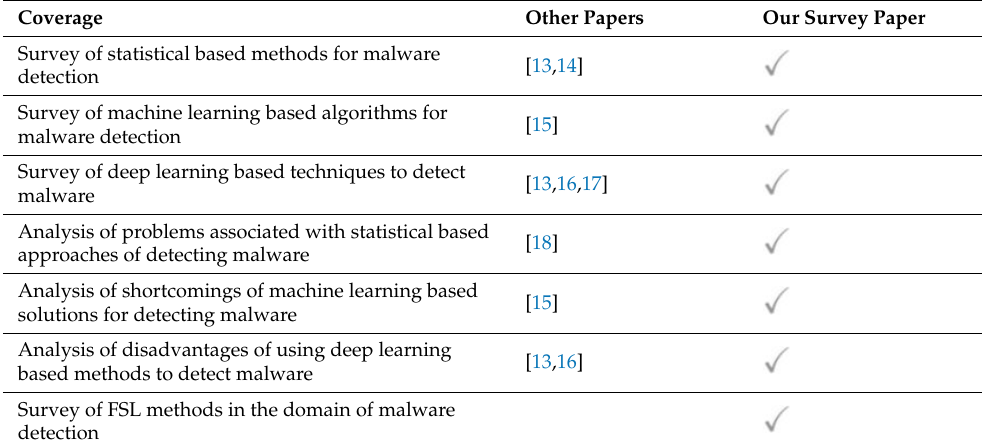
Table 1. Related survey Papers on Malware Detection Approaches.